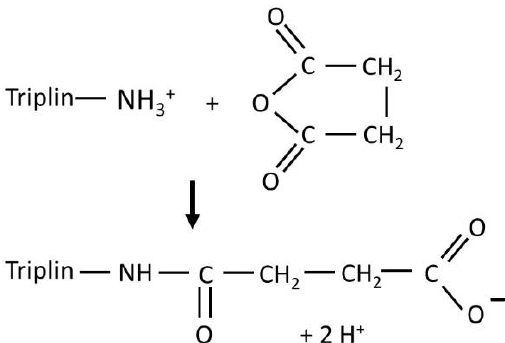
Figure 3. An illustration of the reaction of succinic anhydride with an amino group on